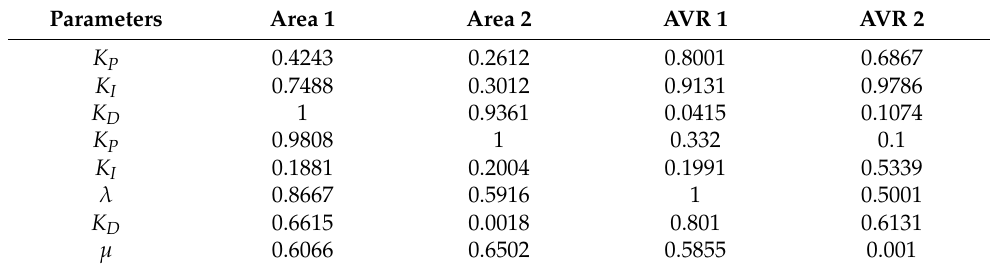
Table 4. CPID-FOPID parameters. Table 3. FOPID parameters.